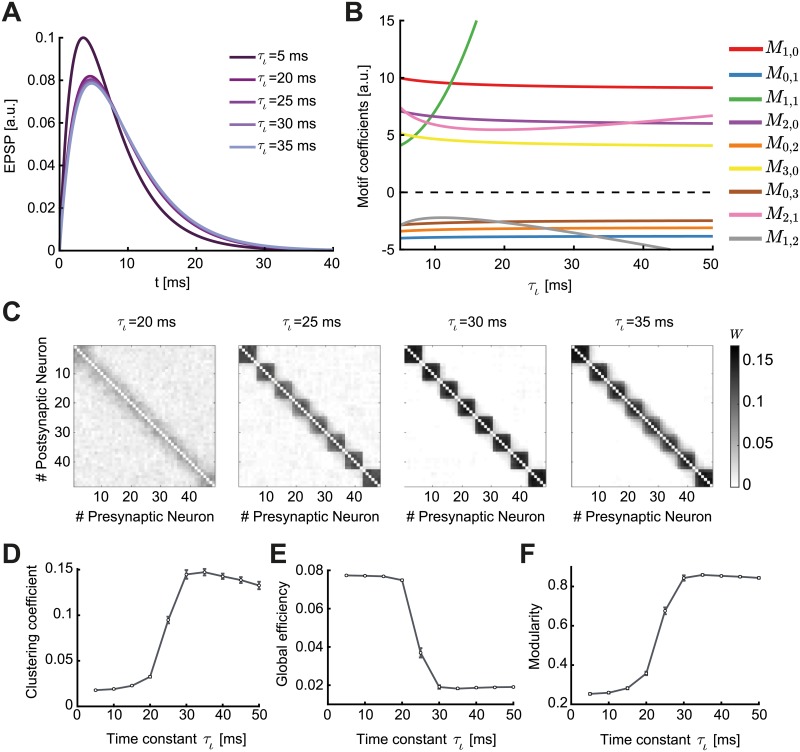
Spontaneous emergence of assemblies due to the modulation of synaptic transmission.A. Varying the time constant τι changes the shape of the EPSC function, shifting its peak by a few milliseconds. B. Relative value of the motif coefficients as a function of τι. While the common input motif M1,1 rapidly assumes dominance, the motif coefficient M1,2 crosses over in strength with the feedback motifs M0,1, M0,2 and M0,3. C. Averaged connectivity matrices over 100 trials at steady state and different values of the time constant τι. Matrices are reordered using the k-means clustering algorithm (see Methods). D. Mean clustering coefficient versus the time constant τι. E. Mean global efficiency versus the time constant τι. F. Mean modularity versus the the time constant τι. All results are calculated from 100 trials at steady state connectivity. Error bars represent the standard error of the mean.